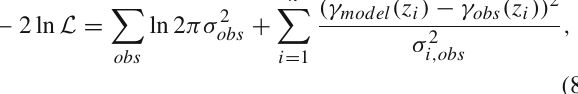
lated by propagating the errors in f ref gas , K , (cid:4) m , cluster z , (cid:4) b , D A ( z ) , and D ref . In addition to these observational A